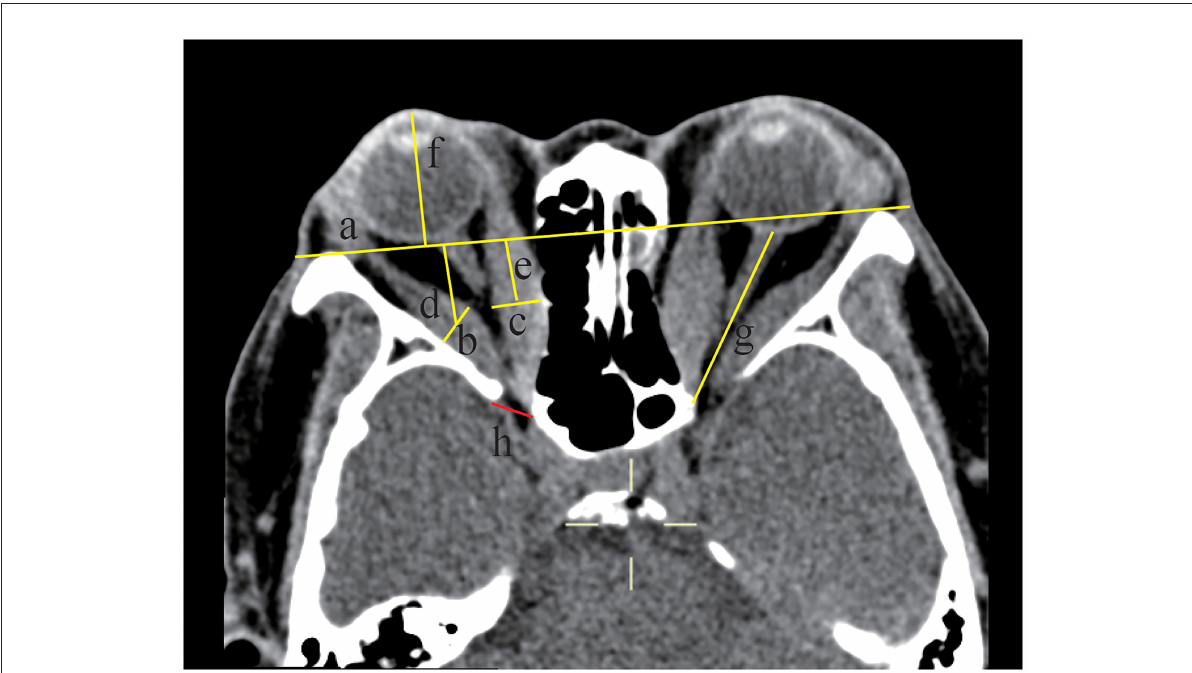
FIGURE2 Soft tissue structures were measured by computed tomography (CT) at the axial section of a 58-year-old female dysthyroid optic neuropathy (DON) patient. The axial section at the midglobe level showed the interzygomatic line (IZ) (labeled line a) and maximum horizontal diameters of the right lateral rectus muscle (labeled line b and the length was 9.11mm) and the medial rectus muscle (labeled line c and the length was 10.48mm). The distance from the midpoint of the maximum muscular diameter of the lateral rectus muscle (labeled line d and the length was 17.47mm) and medial rectus muscle (labeled line e and the length was 13.88mm) to the IZ was recorded. Proptosis of the right eyeball was measured from the center of the anterior cornea to the IZ (labeled line f and the length was 24.66mm). The optic nerve stretch of the left eyeball was measured from the retrobulbar optic nerve to the orbital apex point (labeled line g and the length was 36.21mm). Intracranial fat prolapse was present in the right eye (labeled h), and the red line connected the most inner border of the sphenoid wing and the most anterior border of the sphenoid body groove.